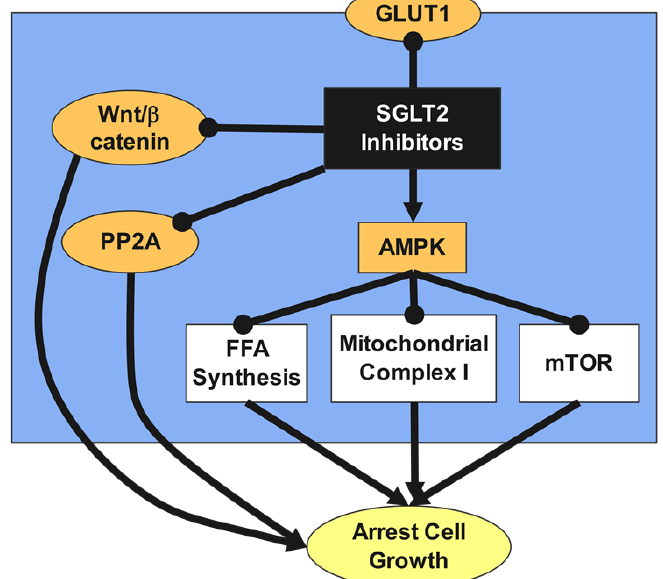
Figure 4. Anticancer effects of SGLT2 inhibitors.